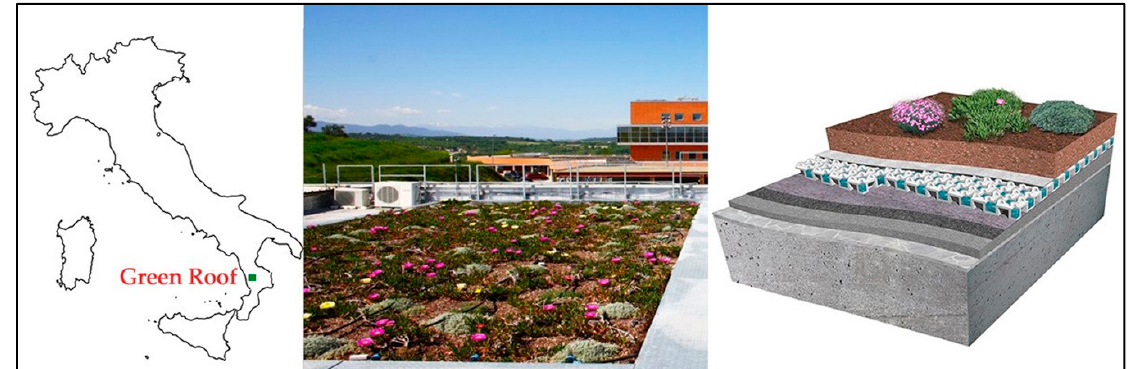
Figure 1. The experimental green roof (GR) located at the University of Calabria, Italy. A map of Italy, with the location of the green roof (left), the GR experimental site (middle), and an axonometric detail stratigraphy (right). All the figures were captured or created by the Urban Hydraulic and Hydrology Laboratory, University of Calabria, Italy.